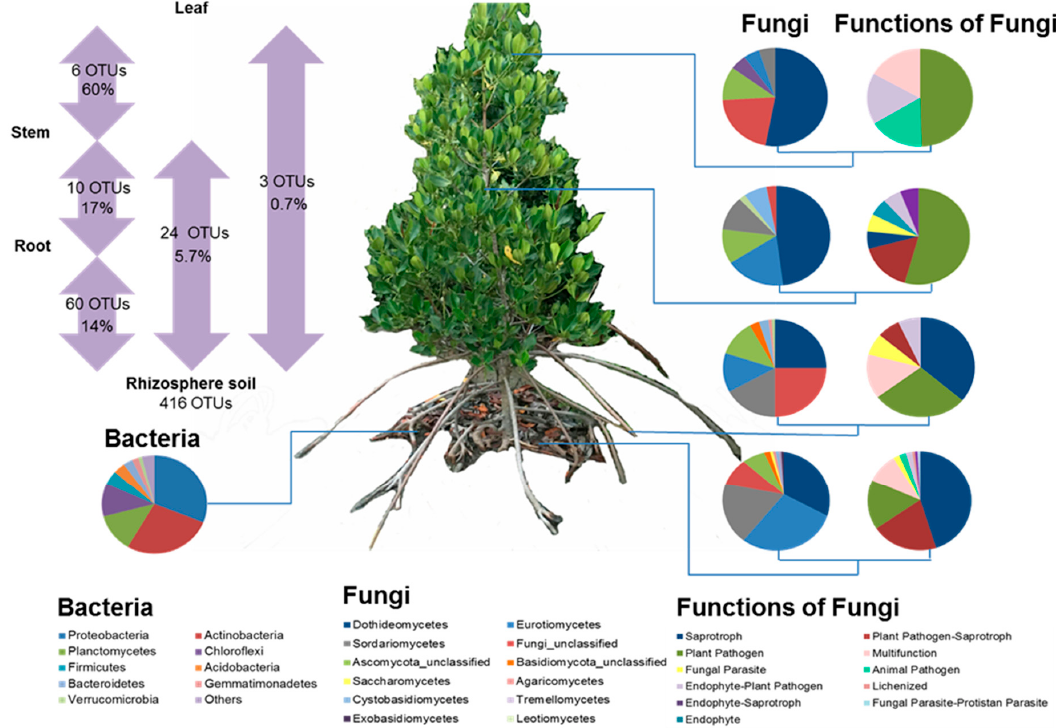
Figure 4. Bacterial taxonomic community composition in the rhizosphere soil and fungal taxonomic community composition in all four rhizosphere soil and plant compartments. Information on the fungal ecological functional groups is also provided. Proportions of fungal OTUs that can colonize at least two of the compartments are shown in the left panel.